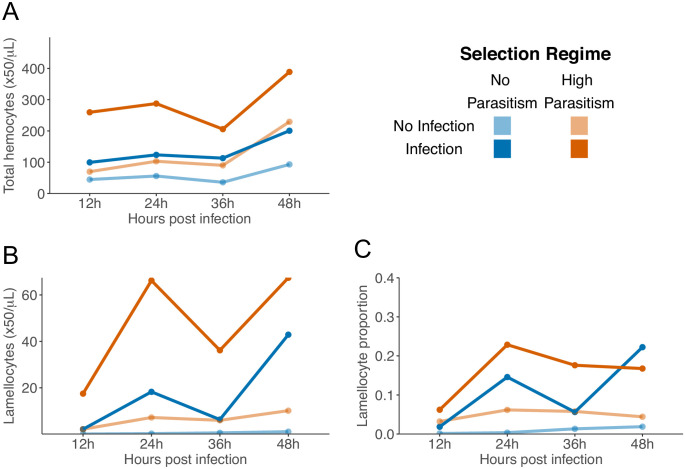
Hemocyte concentrations during development of 3rd instar larvae.Total number of hemocytes (A), lamellocytes (B) and lamellocyte proportions (C) in larvae 12-, 24-, 36-, and 48-hr post infection (dark colours) and corresponding controls with no infection (light colors). Points represent the mean of three biological replicas from each triplicate line of No parasitism (blue) and high parasitism (orange) selection regimes. Restrictions on working hours mean the 12 hr and 36 hr timepoints were performed separately to the 24 hr and 48 hr timepoints.Figure 5—figure supplement 4—source data 1.Hemocyte concentrations during development of 3rd instar larvae.